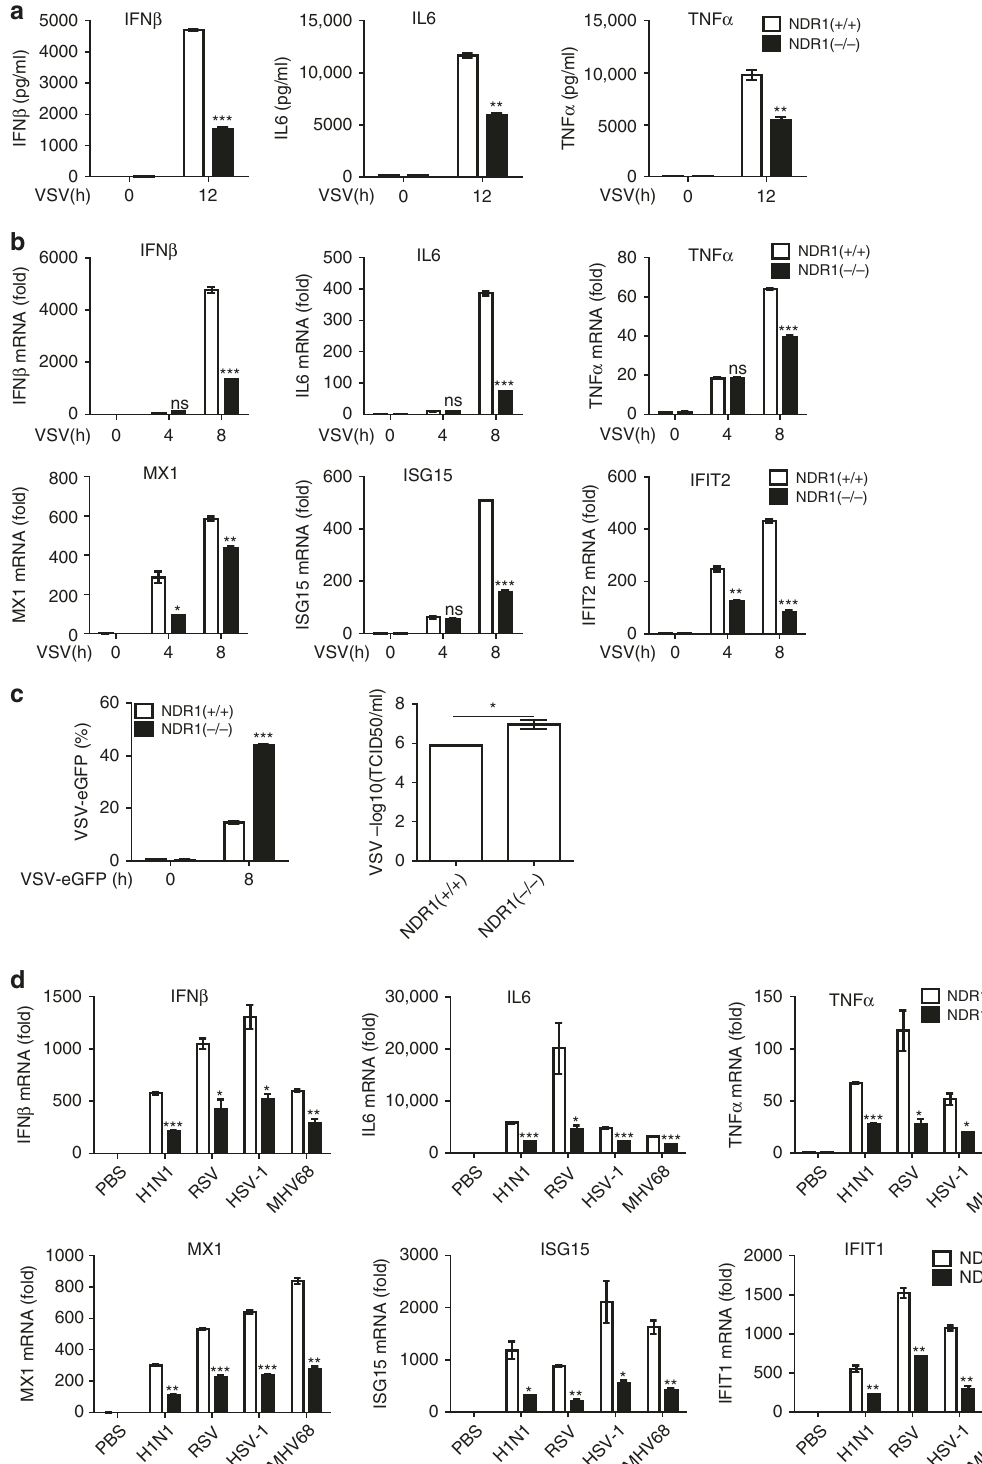
Fig. 2 NDR1 is required for viral infection-induced IFN β , proin fl ammatory cytokines and antiviral ISGs production in macrophages. a Enzyme-linked immunosorbent assay (ELISA) of IFN β , IL6, and TNF α protein in WT and NDR1 − / − PMs infected with VSV. b Real-time PCR analysis of IFN β , IL6, TNF α , and ISGs mRNA in WT and NDR1 − / − PMs infected with VSV. c Fluorescence-activated cell sorting (FACS) and TCID50 (50% tissue culture infective dose) assessing the proliferation level of VSV. WT and NDR1 − / − PMs were infected with VSV-eGFP. The fusion protein fl uorophore was analyzed by FACS. Then, fresh medium with the VSV-eGFP infection was serially diluted on the monolayer of HEK293 cells for 3 – 7 days and TCID50 was measured. d Real-time PCR analysis of IFN β , IL6, TNF α , and ISGs mRNA in PMs infected with H1N1, RSV, HSV, and MHV68 for 8 h. Data are mean ± SD and are representative of three independent experiments. Student ’ s t test was used for statistical calculation. * p < 0.05, ** p < 0.01, *** p < 0.001. See also Supplementary Fig.